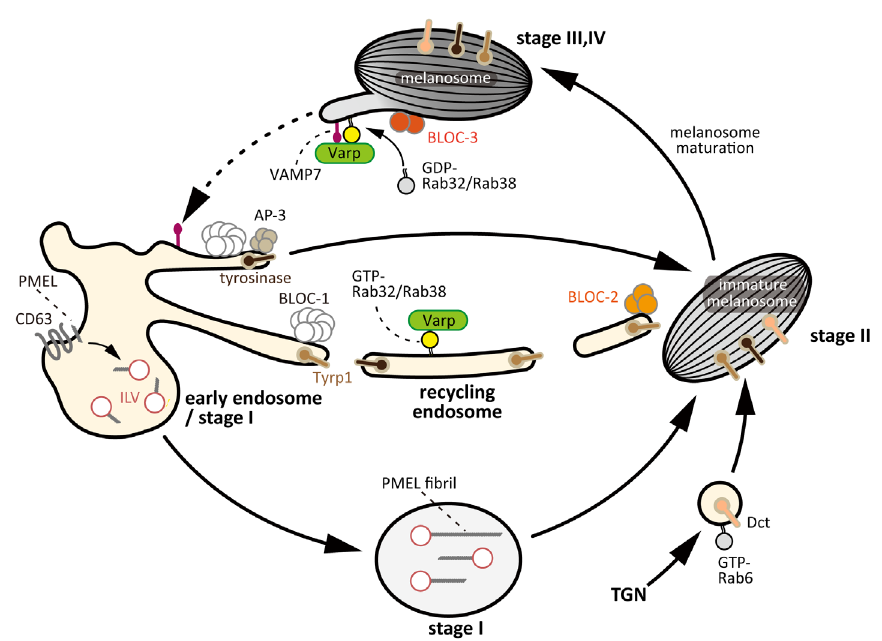
Figure 1. Schematic diagram of endosomal and melanosomal transport systems that have been proposed to regulate melanosome biogenesis. PMEL fibrils emanate from ILVs in the vacuolar portion of early endosomes, a process that requires the functions of CD63 and apolipoprotein E. The PMEL fibrils then form sheets onto which synthesized melanin is deposited. Melanosomal cargoes, including tyrosinase and Tyrp1, are secreted from the microdomains of early endosomes. Rab4A is postulated to regulate the segregation of the melanogenic enzymes from the vacuolar portion of the early endosomes 15 (not depicted in this figure). The BLOC-1/2-dependent pathway regulates the transport of Tyrp1 and a small cohort of tyrosinase, and the AP-3-dependent pathway regulates the transport of a large cohort of tyrosinase. BLOC-1 is an important regulator in the formation of transport carriers in a microtubule- and actin-dependent manner. BLOC- 2 is involved in the fusion of transport carriers with maturing melanosomes, and BLOC-3 is required for the activation of Rab32/Rab38 on mature melanosomes. The Rab32/Rab38–Varp complex is required for the recovery of melanosomal cargoes, such as VAMP7, from mature melanosomes (retrograde trafficking), and is also required for the transport of melanogenic enzymes from early endosomes to maturing melanosomes (anterograde trafficking). The dotted arrow indicates an as-yet-unidentified transport pathway. AP, adaptor protein; BLOC, biogenesis of lysosome-related organelles complex; ILV, intraluminal vesicle; PMEL, premelanosome protein; TGN, trans -Golgi network; Tyrp1, tyrosinase-related protein 1; VAMP, vesicle-associated membrane protein; Varp, VPS9-ankyrin-repeat